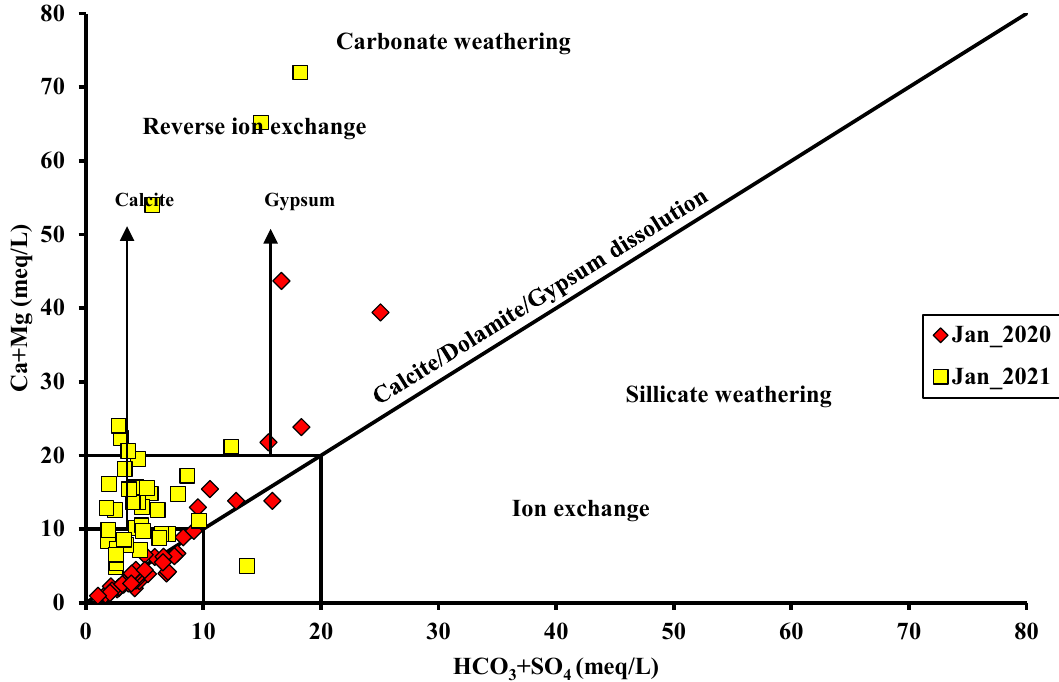
Figure 11. Scatter plot for Ca 2+ + Mg 2+ versus HCO 3 − + SO 4 − .